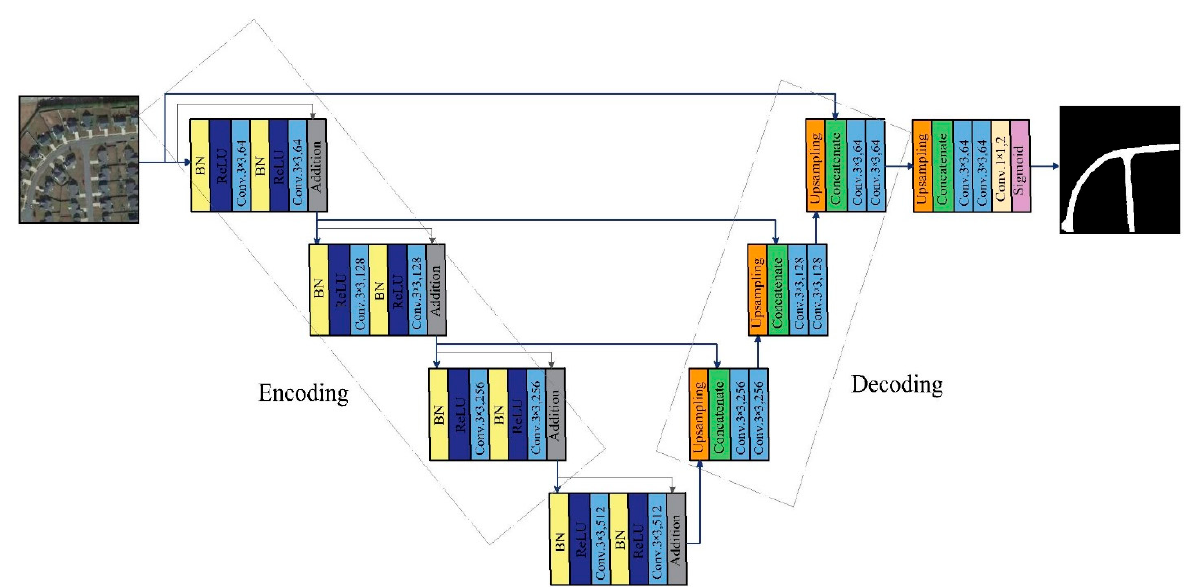
Figure 1. The basic architecture of the previous work by the authors [42].